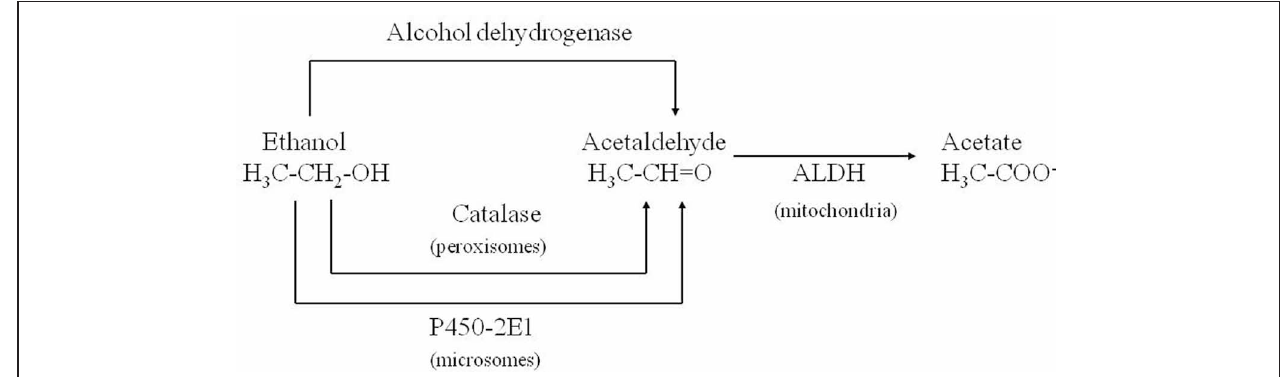
FIGURE 2 | Role of CYP 2E1 in metabolizing ethanol and